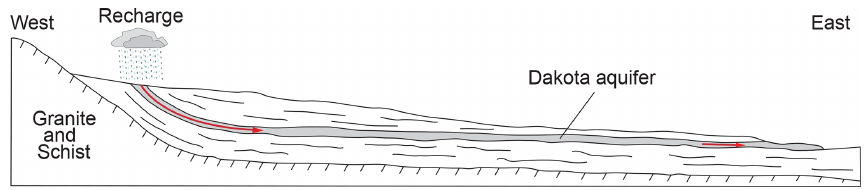
Figure 3. The profile of the Dakota confined aquifer and the confined flow bounded by aquitards (modified from Darton, 1897).